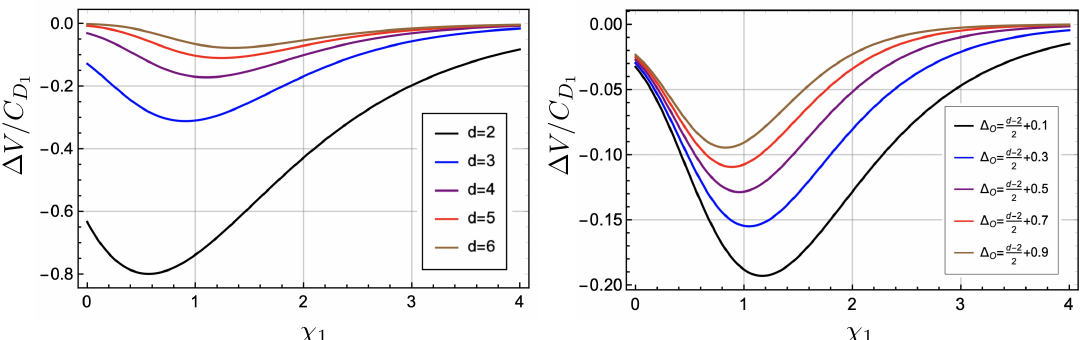
Figure 10. ANE for localized shocks as a function of the transverse coordinate of signal χ 1 for several values of d (left panel) and for several values of ∆ O (right panel). We plotted (4.27) as ∆ O Γ(2∆ O ) ∆ V/C D where C D ≡ α h b 2 vol ( S d − 2 ) . We fixed ∆ O = d − 2 O 4 1 1